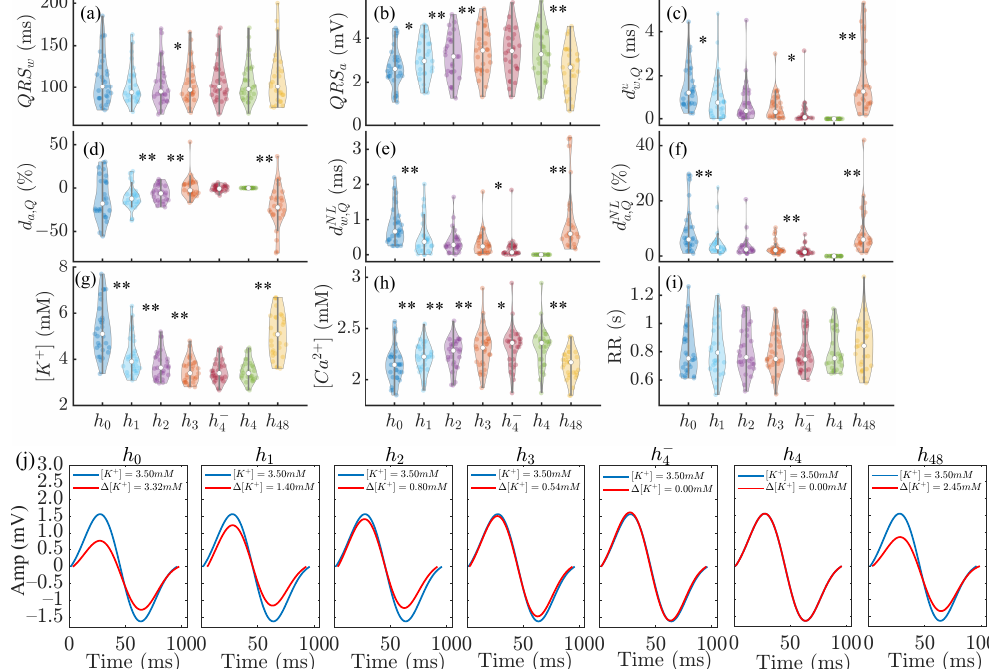
Figure 4. Panels ( a – f ): changes in QRS w , QRS a , d u ( g – i ): corresponding variations in [ K + ] , [ Ca 2 + ] and RR. In panels ( a – i ), * denotes p < 0.05 and ** denotes p < 0.01. In each panel, the central white dot indicates the median. Each dot corresponds to an individual patient. Panel ( j ): MWQRS (red) of a patient at different HD stages and reference MWQRS (blue). ∆ denotes the change in [ K + ] with respect to the end of HD ( h 4